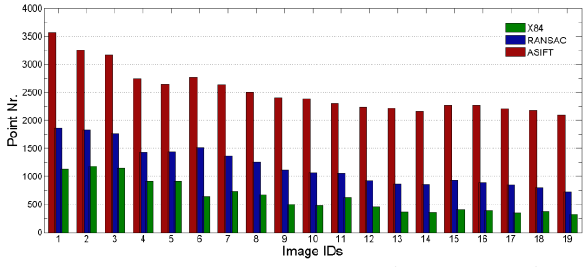
Figure 5. Feature point correspondences for 19 images of the farm building dataset, correspondences after ASIFT matching (red), the results after RANSAC filtering (blue) and after statistical outlier removal X84 (green)